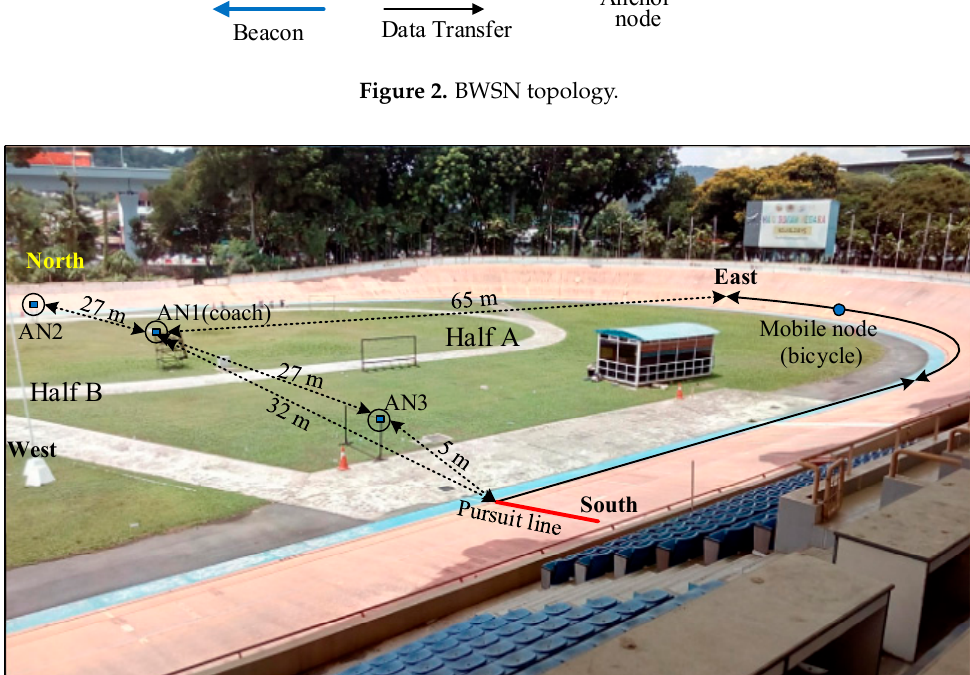
Figure 3. The outdoor experimental setting at the track cycling field (Cheras velodrome).